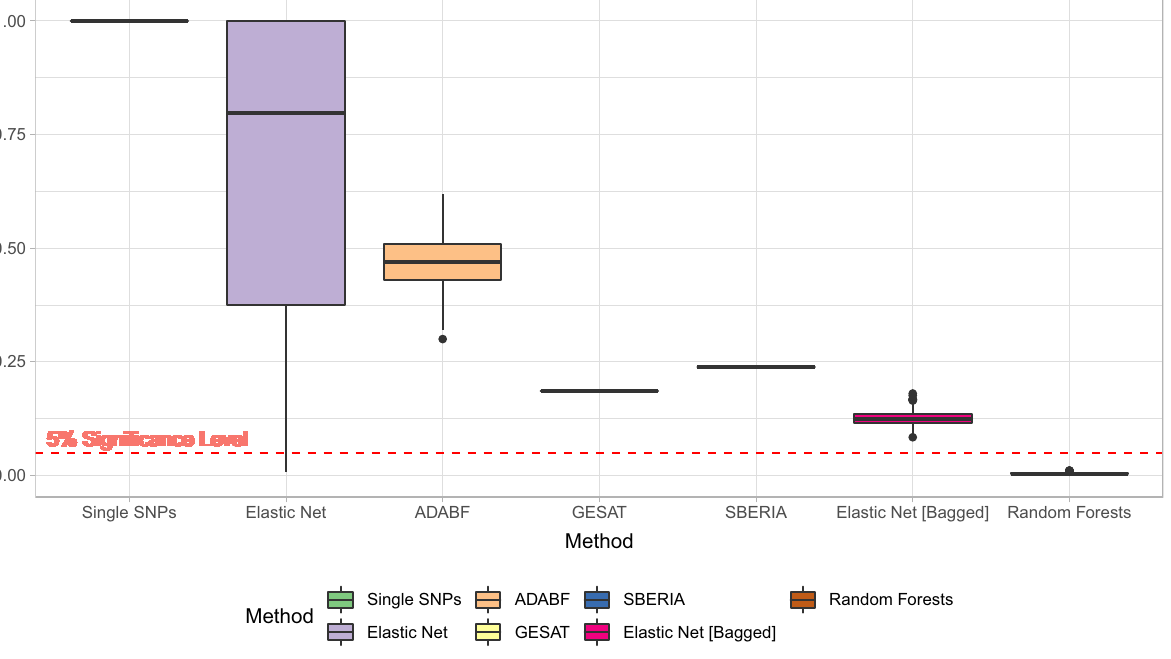
Figure 6. p values of 1000 independent applications of the GxE interaction testing procedures to the considered real data set from the SALIA cohort study analyzing the association-based SNP selection containing 87 SNPs. For elastic net, the train/test data splits changed. For the two bagging-based tests, the bootstrap samples changed. For ADABF, the random sampling from the null distribution of GxE interaction coefficients changed. The single-SNP-based test, GESAT, and SBERIA were applied only once, since there is no randomness involved in the application of these